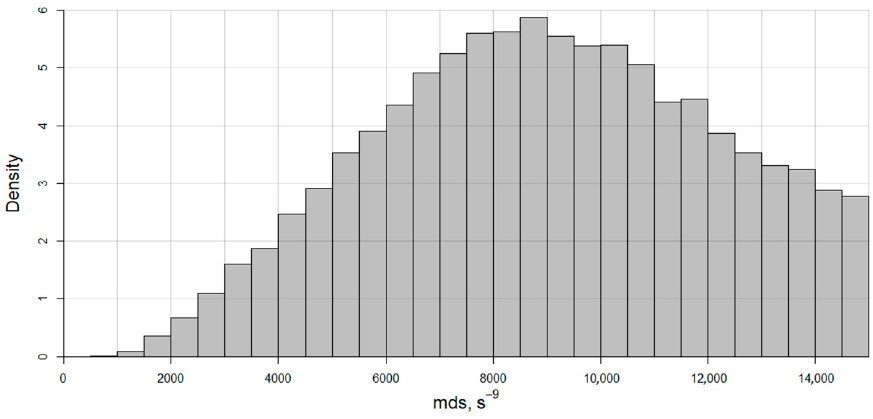
Figure 2. The MDS parameter distribution.